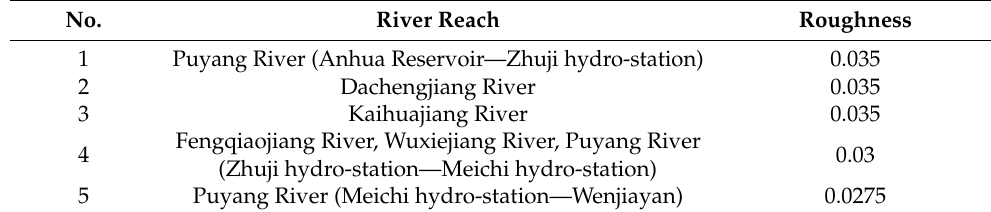
Table 4. Hydraulic roughness coefficient of Puyang River.